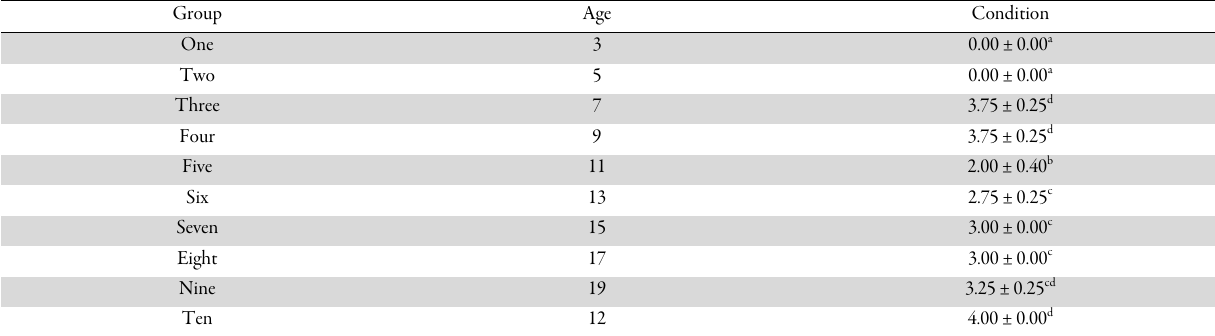
Table 5. Assessment of body and behavioral condition of alloxan-induced diabetic rats monitored for 96